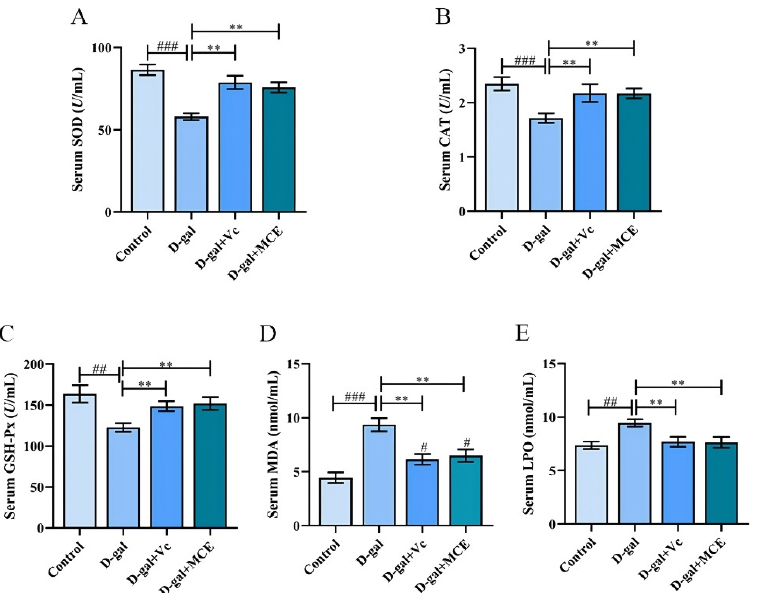
Figure 5. Effects of MCE on the activity of antioxidant enzymes and the level of lipid peroxidation. SOD ( A ), CAT ( B ), GSH-Px ( C ), MDA ( D ), LPO ( E ). Data were reported as mean ± S.D. of 20 mice in each group. ### p < 0.001, ## p < 0.01, # p < 0.05 vs. control group; ** p < 0.01 vs. D -gal group.